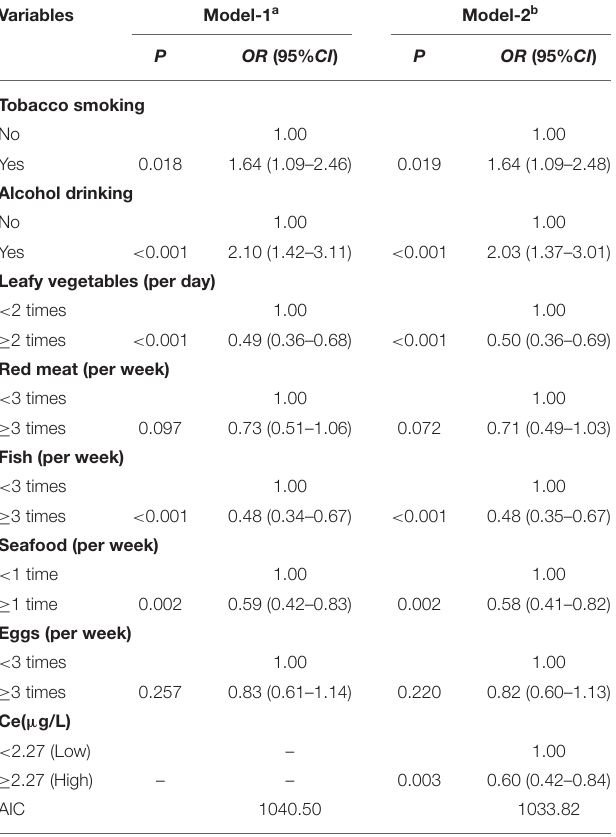
TABLE 4 | Multivariate unconditional logistic regression analysis of influencing factors of oral cancer.